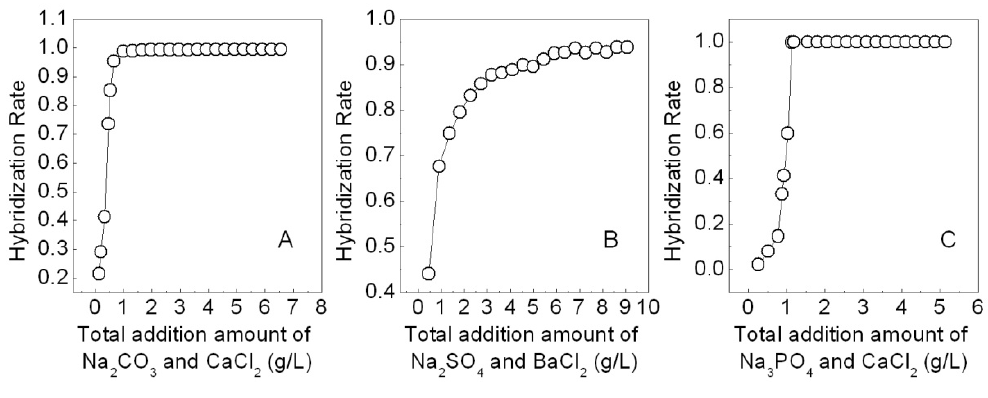
CO and CaCl (molar ratio 1:2) on the 2 3 2 SO and BaCl (molar ratio 1:1.5) on the hybridization 2 4 2 PO and CaCl (the molar ratio 1:2) on the hybridization of 3 4 2